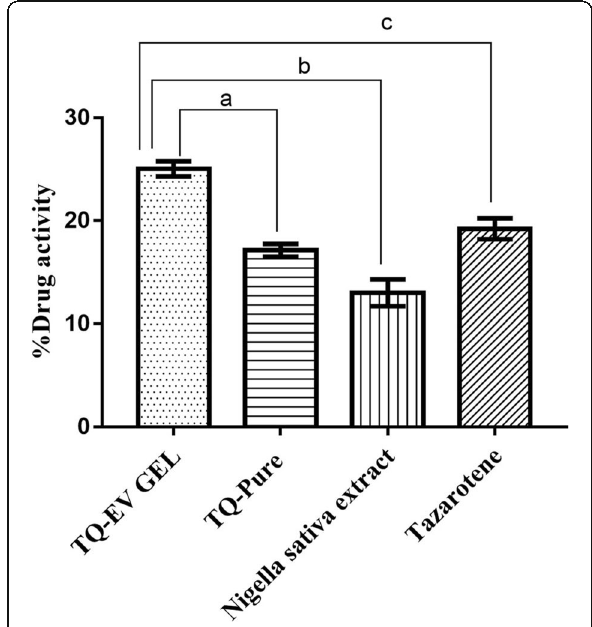
Fig. 5 Effect of TQ-loaded EV gel, TQ suspension, Nigella sativa and Tazarotene on % Drug activity. Results were shown as mean ± standard error mean analyzed via. One way ANOVA followed by Dunnett ’ s multiple comparison tests. a P < 0.001 vs TQ suspension; b P < 0.001 vs Nigella sativa extract and; c P < 0.001 vs